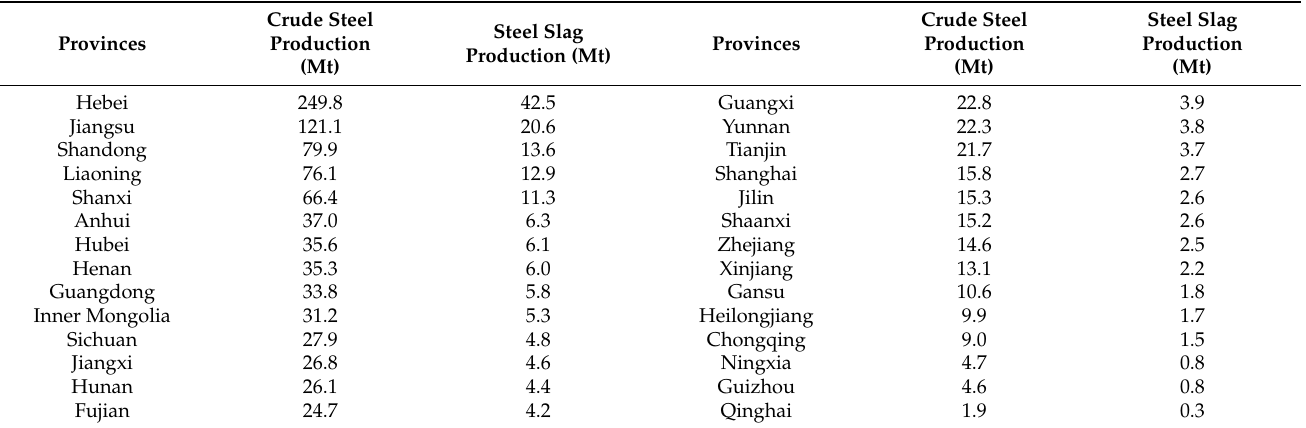
Table 3. Crude steel and steel slag production in China by province in 2020